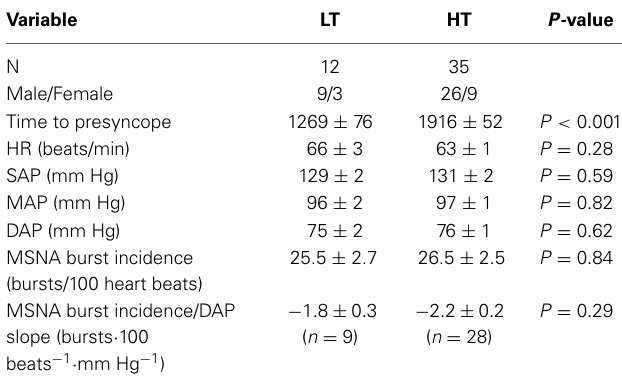
Table 1 | Hemodynamic and MSNA variables at baseline.